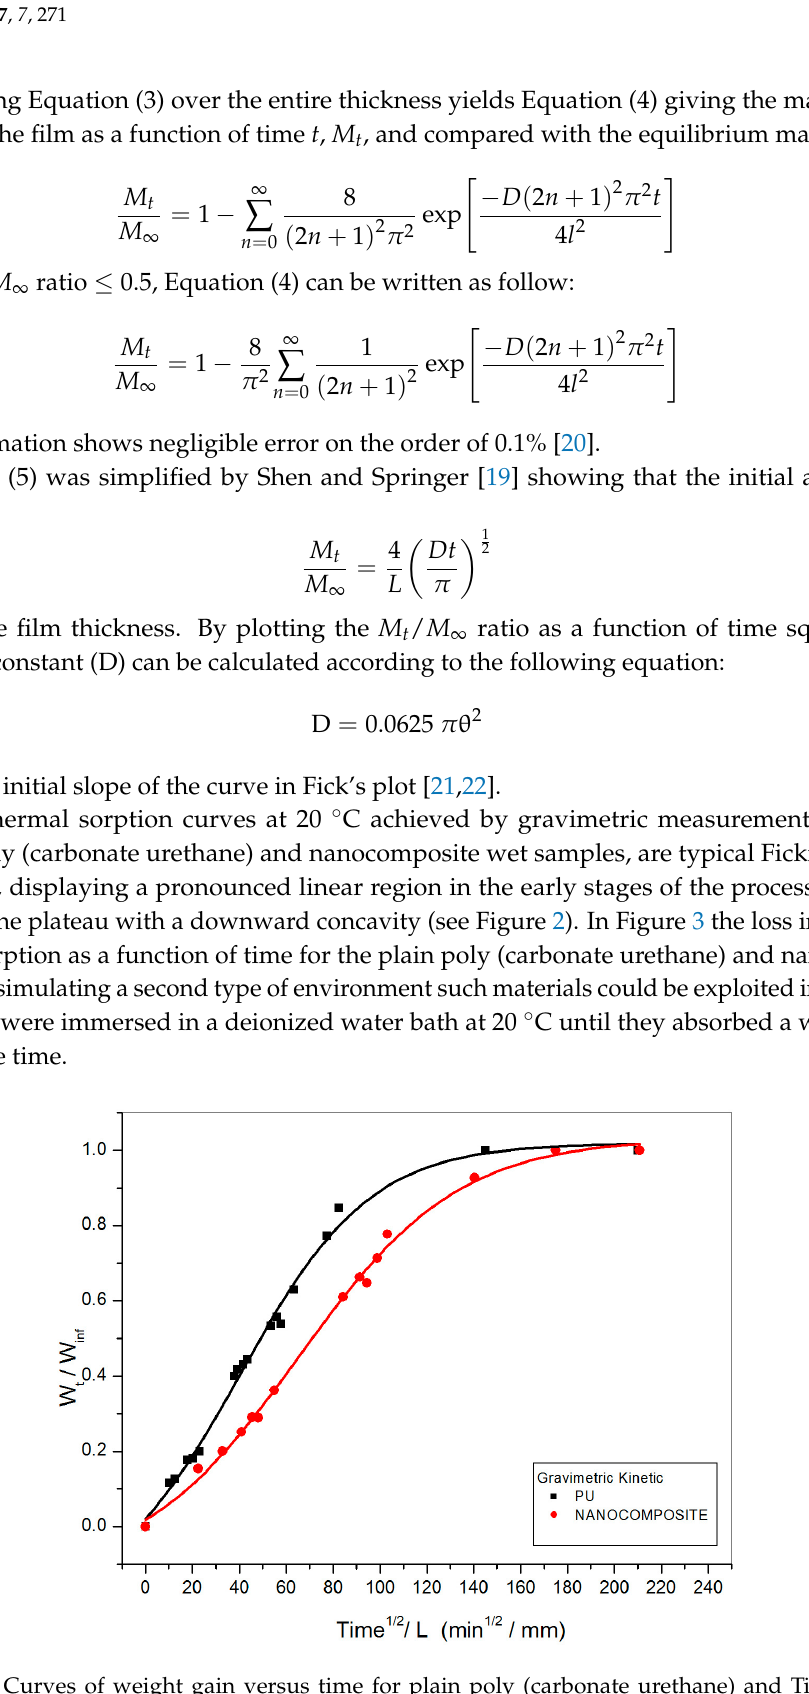
Figure 2. Curves of weight gain versus time for plain poly (carbonate urethane) and TiO 2 /poly (carbonate urethane) nanocomposite systems.